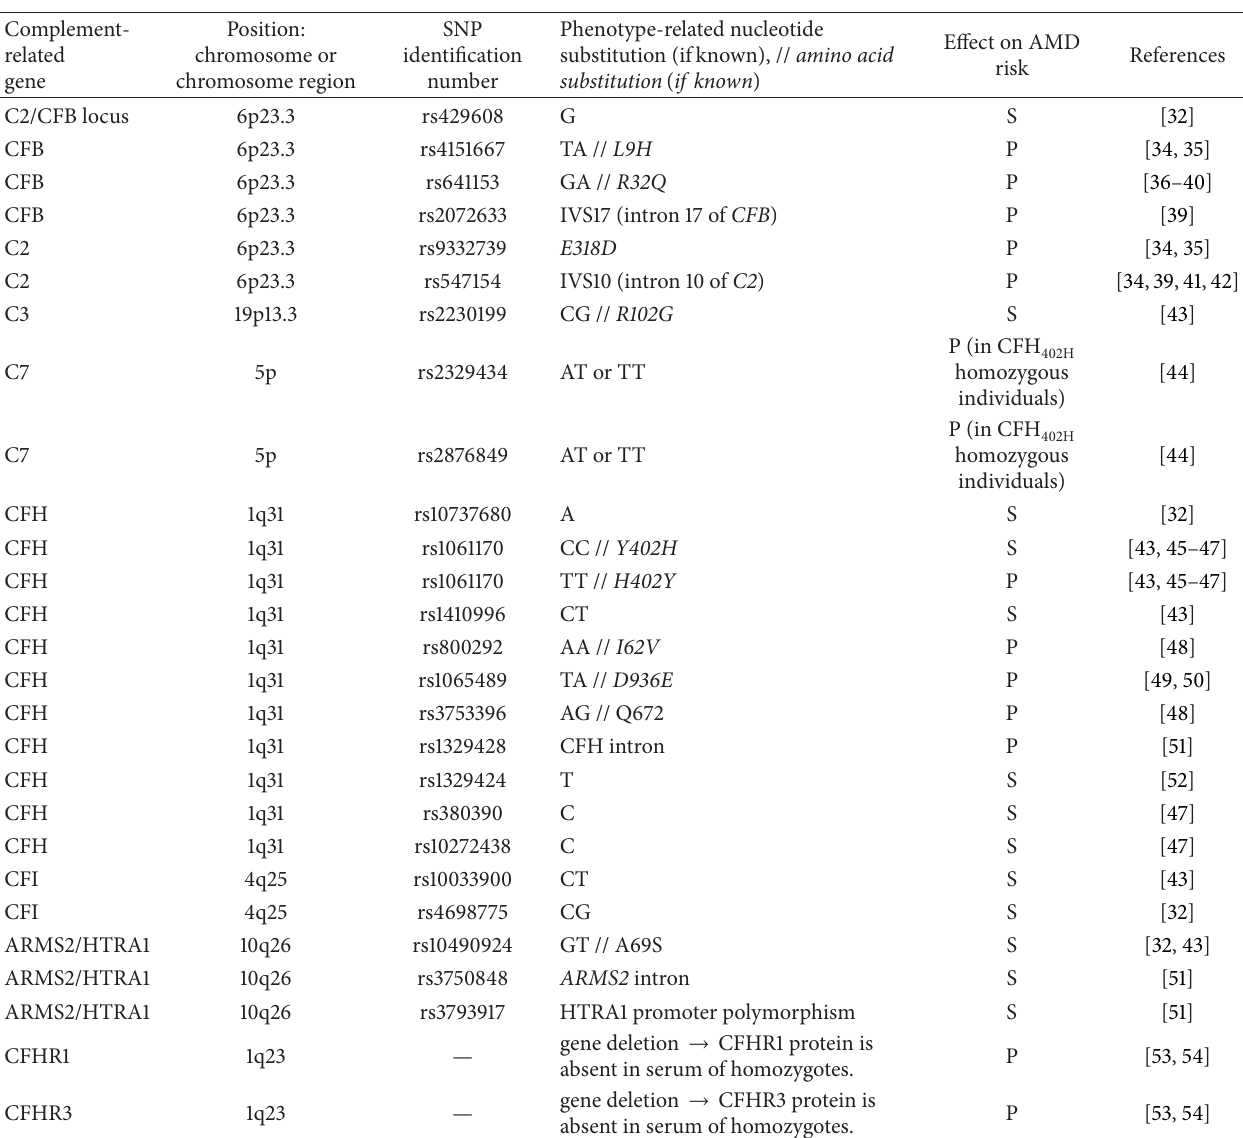
Table 1: Summary of single-nucleotide polymorphisms in genes related to complement system that are associated with increased or decreased risk of AMD